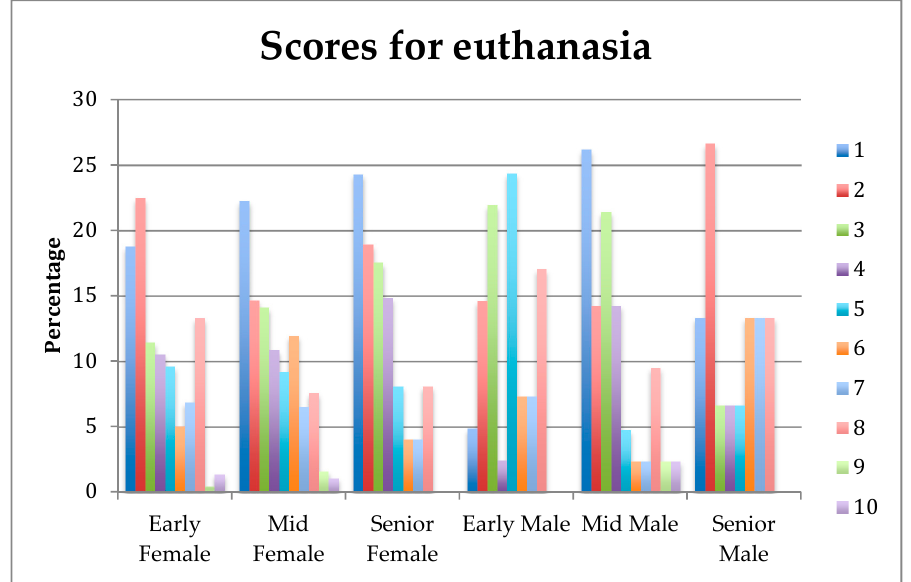
Figure 4. Percentage scores for female ( n = 671) and male ( n = 145) students from the Early, Mid, and Senior stages-of-study rating (1 = extremely important, 10 = least important) of the importance of their understanding of euthanasia of production animals on their first day in